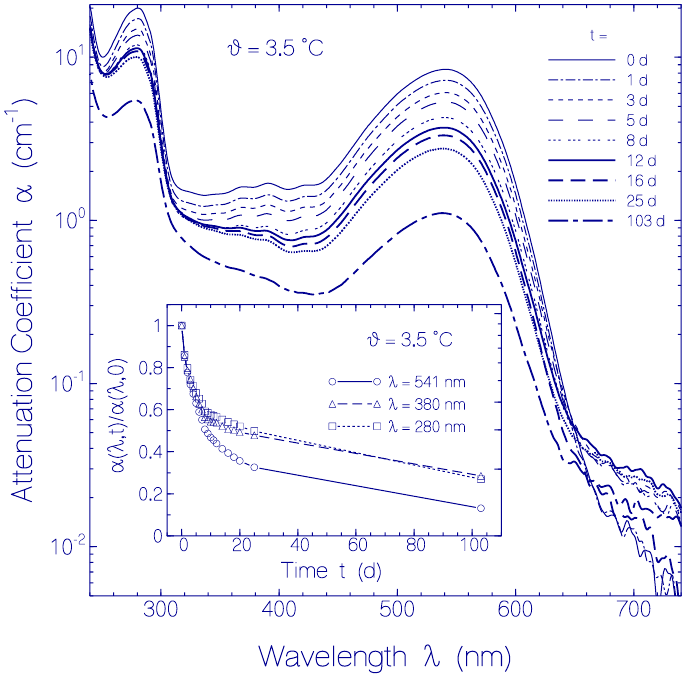
Figure 5. Temporal attenuation coefficient spectra development of CaRh in pH 7.3 HEPES/MOPS buffer at 3.5 °C. Main part: Attenuation coefficient spectra measured after indicated storage times. Inset: Attenuation coefficient ratio α ( λ , t )/ α ( λ , t = 0 ) for the wavelengths λ = 541 nm (circles), 380 nm (triangles), and 280 nm (squares).